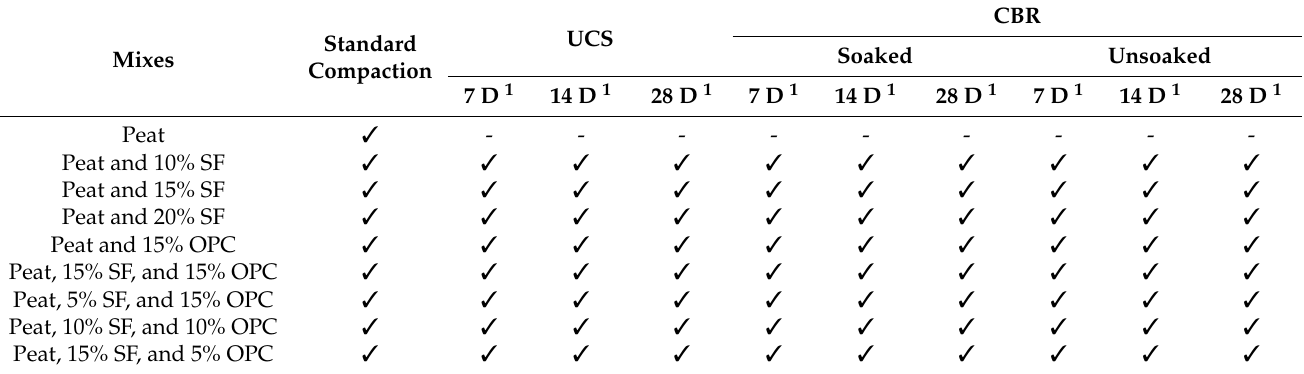
Table 4. Standard compaction and mechanical property testing